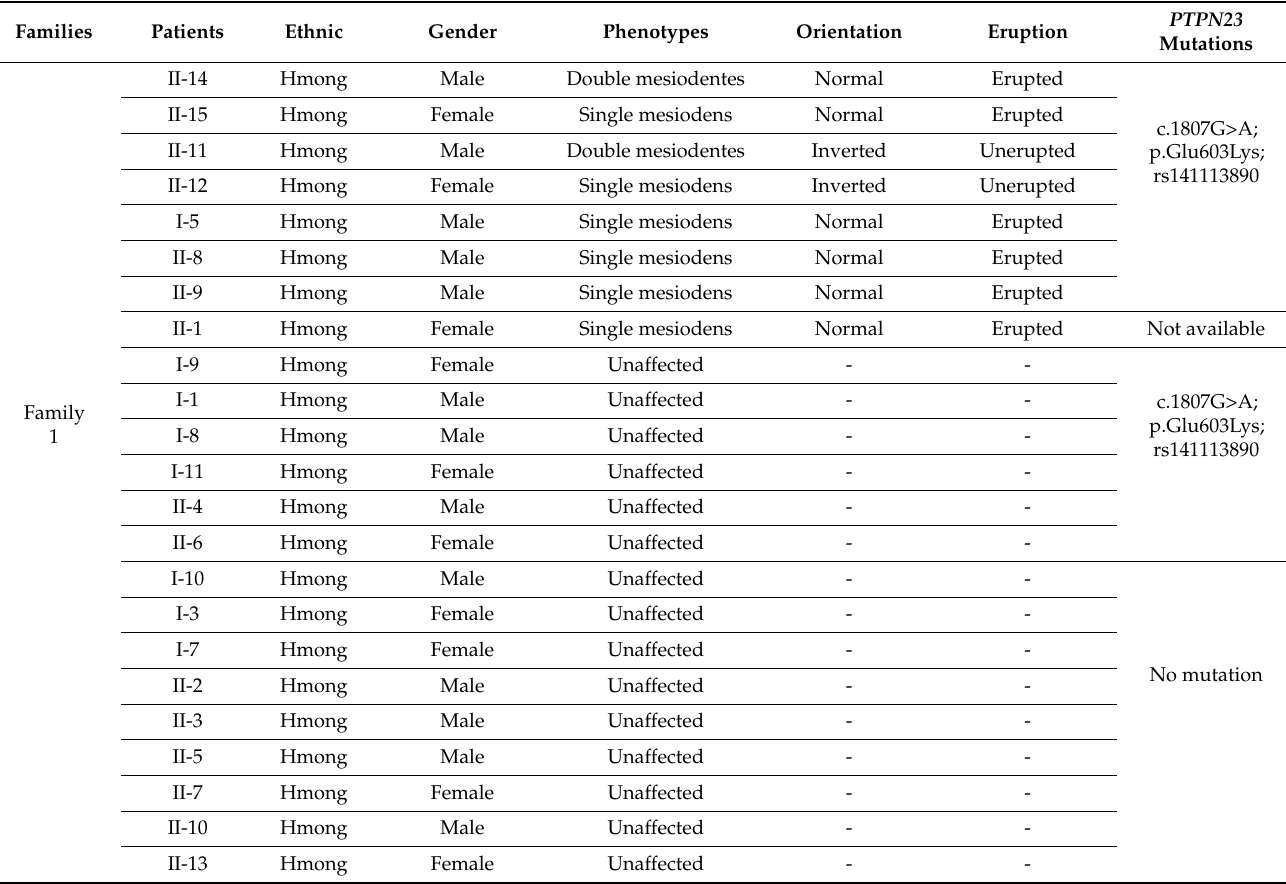
Table 4. Clinical and molecular findings of patients and their family members (NM_015466.4;